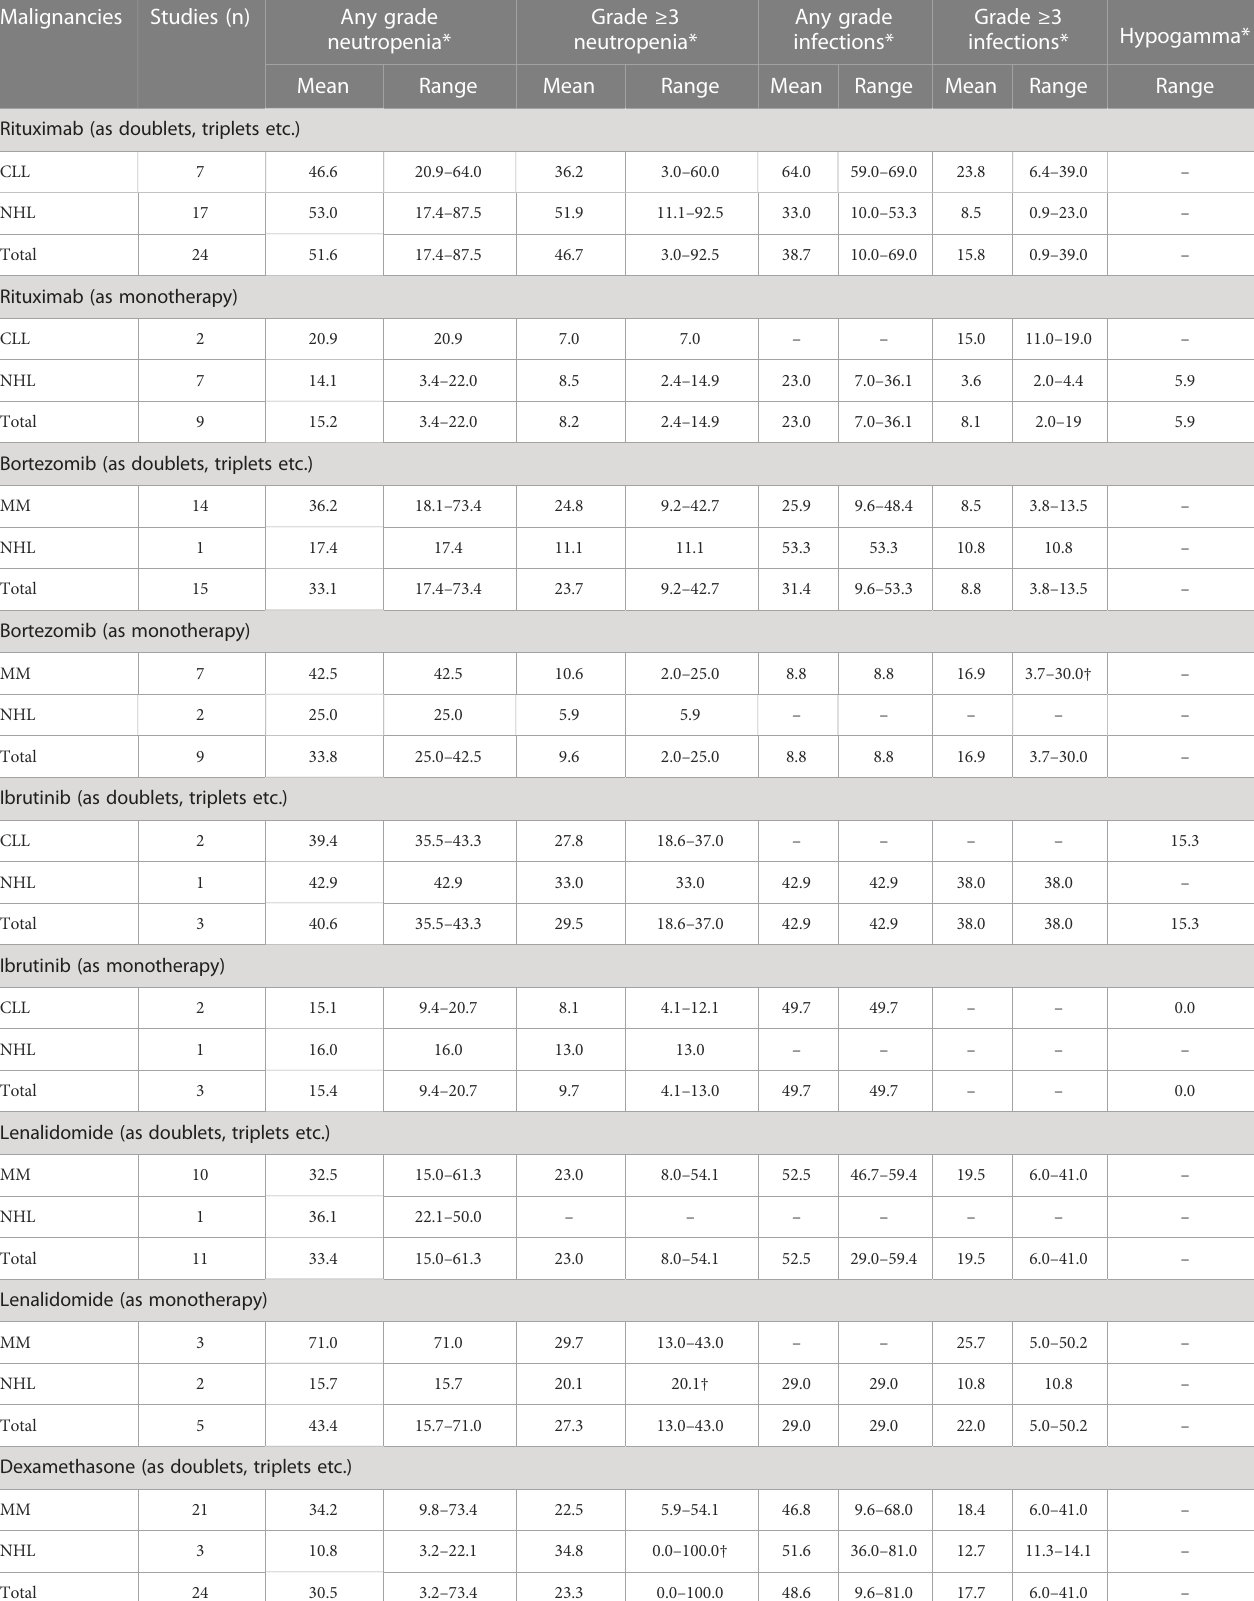
TABLE 5 Percentages of patients with CLL, MM, and NHL treated with rituximab, bortezomib, ibrutinib, lenalidomide, or dexamethasone as monotherapy or in combination with other therapies who had infections (any grade and grade ≥ 3), neutropenia (any grade or grade ≥ 3), or hypogammaglobulinemia. Malignancies Studies (n) Any grade Grade ≥ 3 Any grade Grade ≥ 3 neutropenia* neutropenia* infections* infections* Hypogamma* Mean Range Mean Range Mean Range Mean Range Range Rituximab (as doublets, triplets etc.)